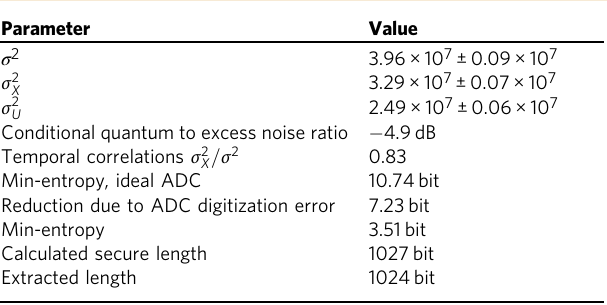
Table 1 Summary of the parameters determined by system